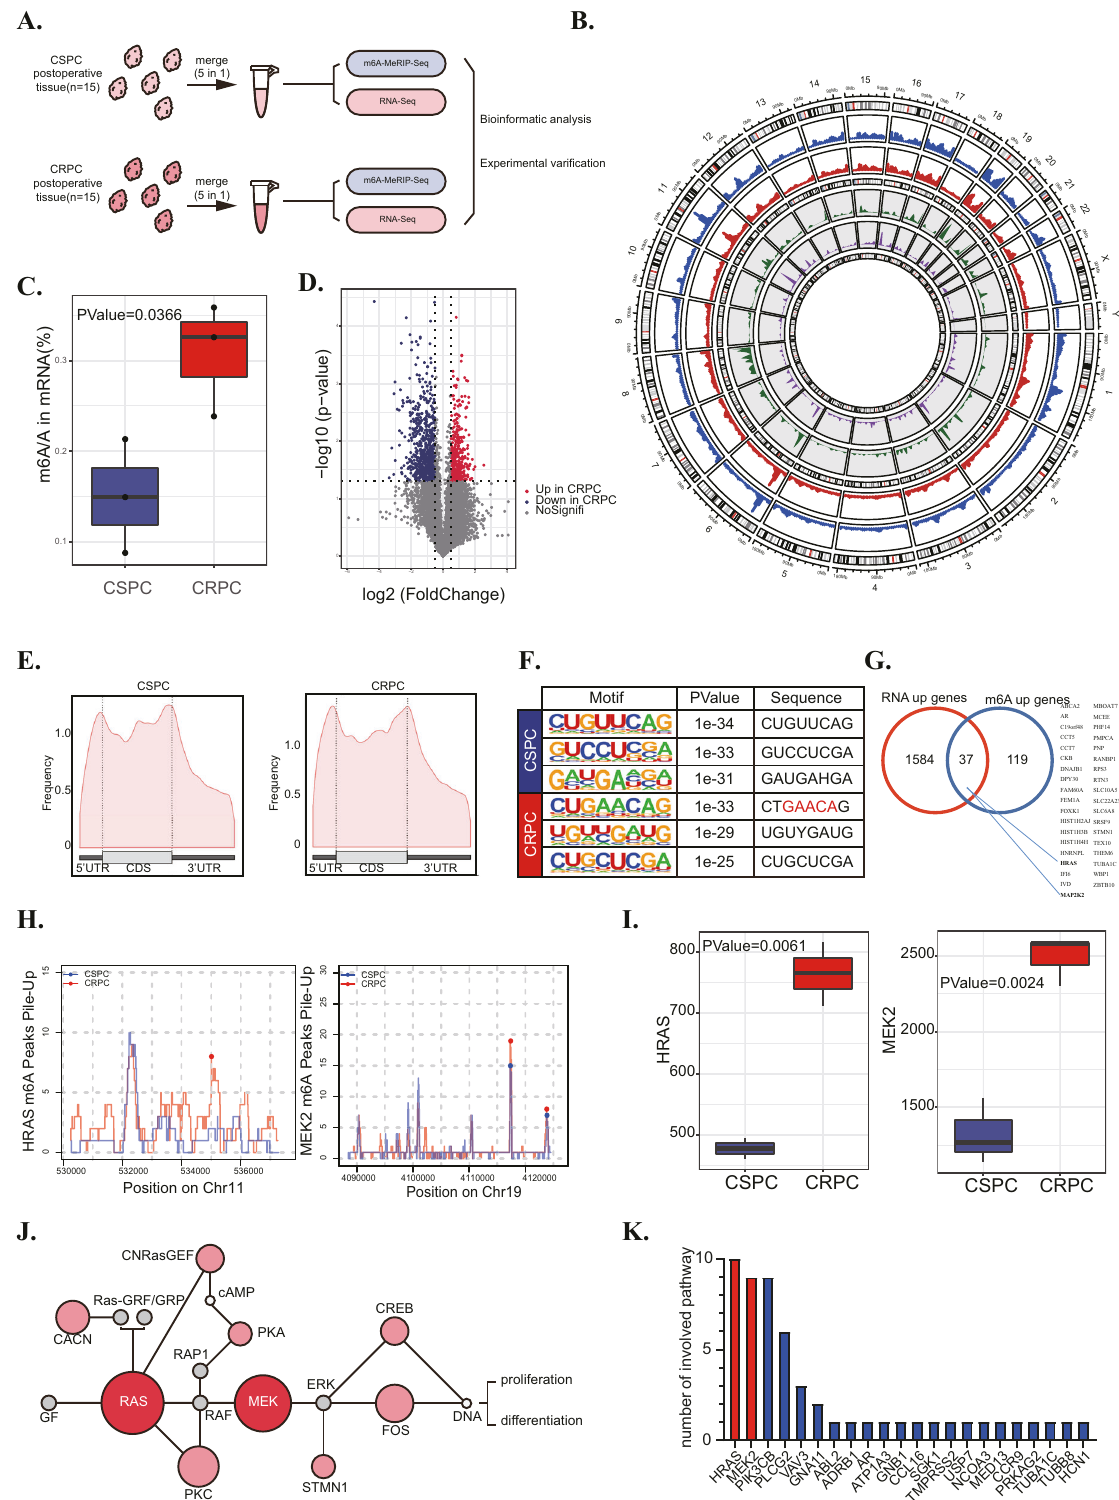
MEK2 gene through m 6 A. Finally, METTL3 was upregulated and the ERK pathway was activated in drug-resistant cells. In vitro and in vivo experiments have con fi rmed that ASO targeting METTL3 can reduce the proliferation of drug-resistant prostate cancer when combined with Enzalutamine.